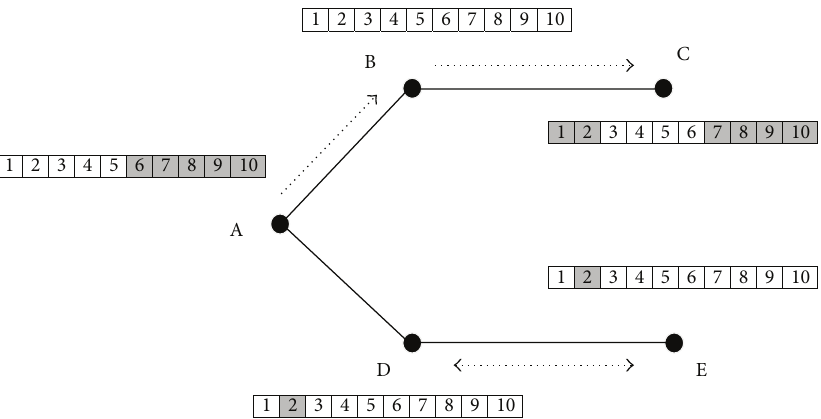
Figure 2: Bandwidth calculation interfered by hidden and exposed terminal